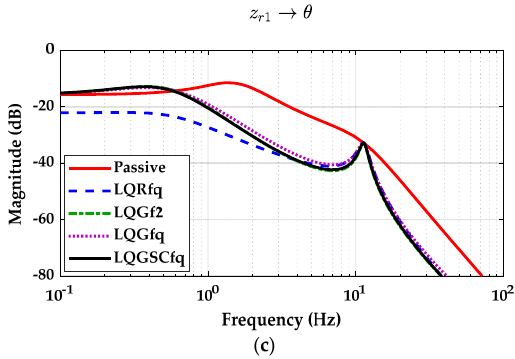
Figure 8. Frequency responses from the road profile z r 1 to each output for LQG case. ( a ) Vertical acceleration of the sprung mass; ( b ) Roll angle of the sprung mass; ( c ) Pitch angle of the sprung mass.